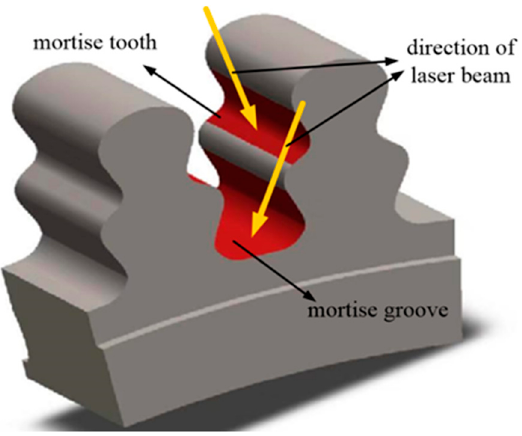
Figure 1. Schematic diagram of oblique laser shock processing of mortise tooth and groove.